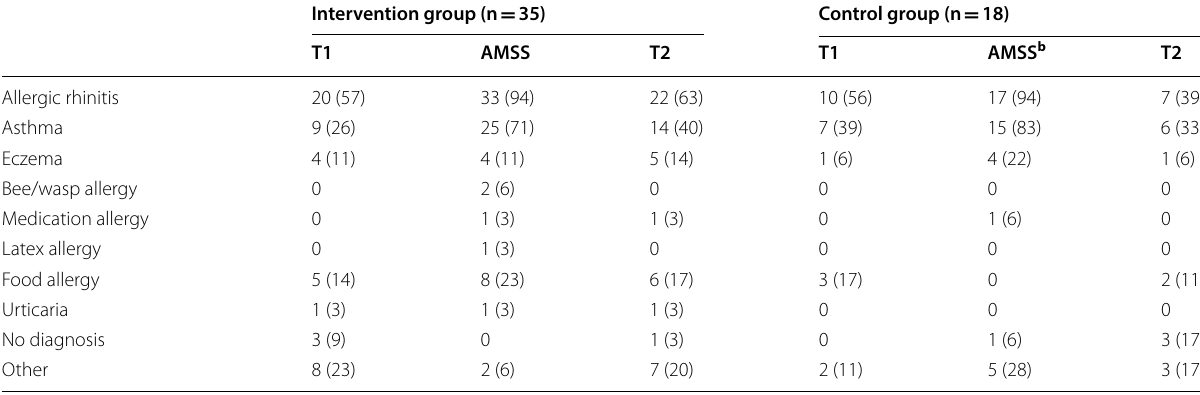
Table 2 Diagnoses a reported by the GPs in intervention group and control group at T1 and T2 and the probable diagnosis by the AMSS (more than one diagnosis possible per